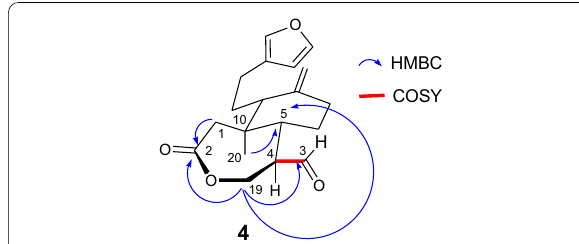
Fig. 1 Selected key 1 H– 1 H COSY and HMBC correlations of compound